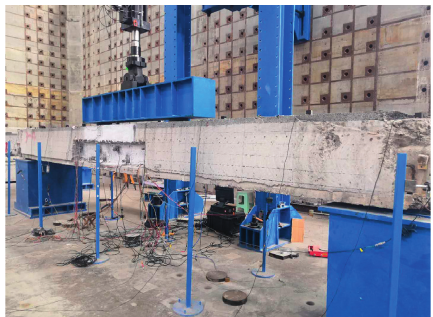
Figure 5: Loading device for